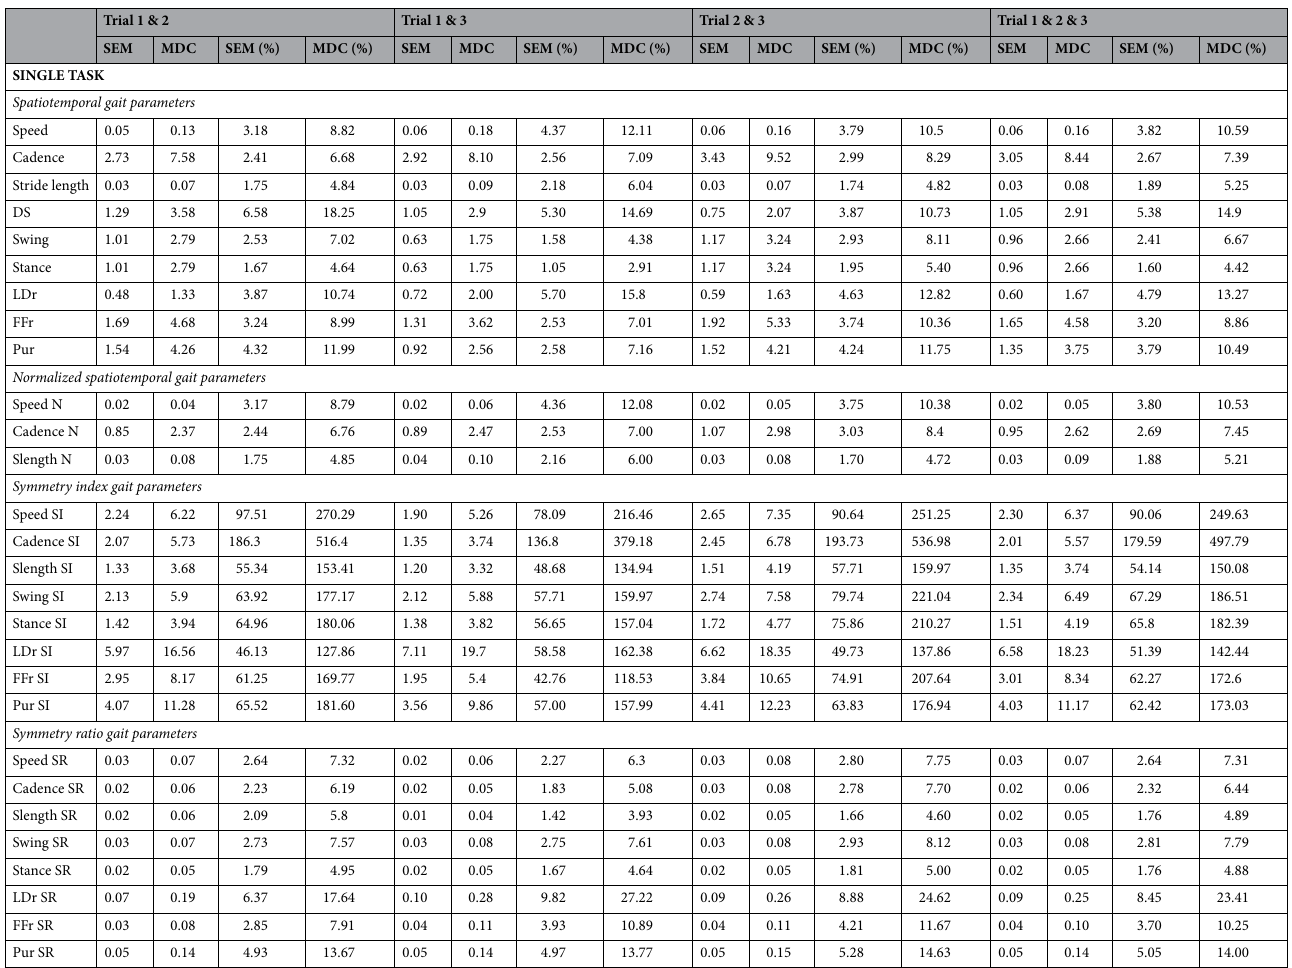
Table 4. Standard error of measurement (SEM) and minimal detectable change (MDC) for trial 1 and 2, 1 and 3, 2 and 3 and 1, 2 and 3 in single task condition. Abbreviations: SEM = standard error of